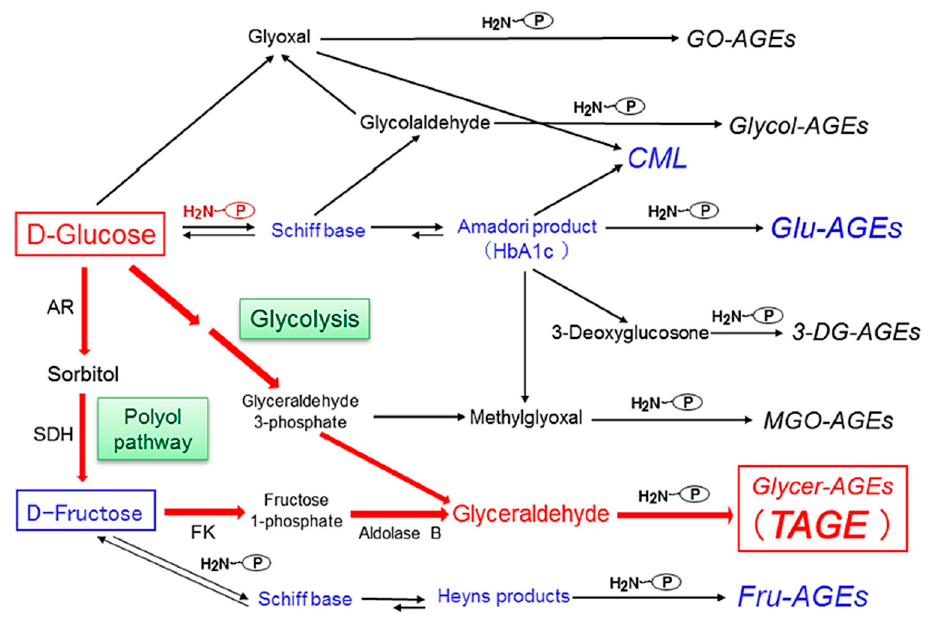
Figure 1. Alternative routes for the generation of advanced glycation end-products in vivo : Reducing sugars, such as glucose, fructose, and glyceraldehyde, which are known to react non-enzymatically with the amino groups of proteins to form reversible Schiff bases and Amadori products/Heyns products. These early glycation products undergo further complex reactions, such as rearrangement, dehydration, and condensation, to become irreversibly cross-linked, heterogeneous fluorescent derivatives, termed advanced glycation end-products (AGEs). Glu-AGEs: glucose-derived AGEs; Fru-AGEs: fructose-derived AGEs; Glycer-AGEs: glyceraldehyde-derived AGEs; Glycol-AGEs: glycolaldehyde-derived AGEs; MGO-AGEs: methylglyoxal-derived AGEs; GO-AGEs: glyoxal-derived AGEs; 3-DG-AGEs: 3-deoxyglucosone-derived AGEs; CML: N ε -(carboxymethyl)lysine; P-NH2: free amino residue of a protein; AR: aldose reductase; SDH: sorbitol dehydrogenase; FK: fructokinase; HbA1c: hemoglobin A1c; TAGE: toxic AGEs.